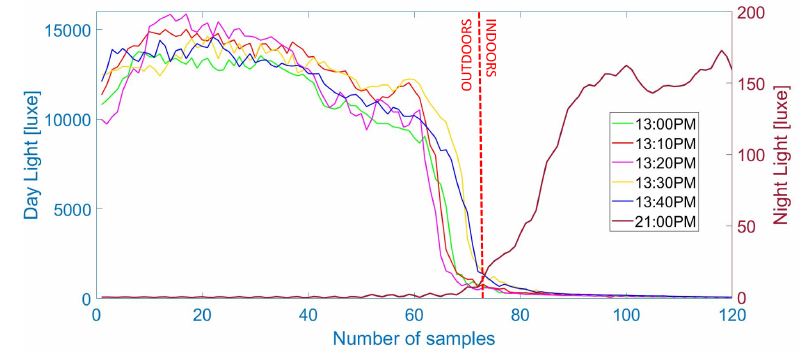
Figure 2. Light data from six outdoor–indoor transitions (OITransitions) collected during the same day, five during day time and one during night. As can be seen, during the OITransition (after the 70th sample), the light intensity rapidly decreases during the day ( left axis ) and increases during the night ( right axis